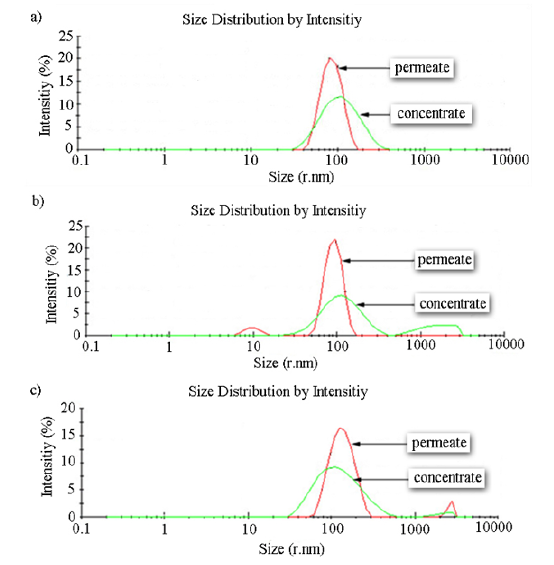
Figure 3. Drop size distribution for feed and permeate from experiment with applied TMP of a) 1 bar, b) 3 bar, c) 5 bar.